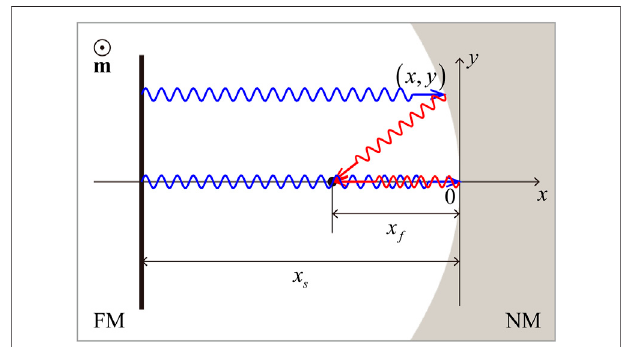
FIGURE 1 | Schematic of the fi lm edge for total-re fl ection focusing of spin waves. The static magnetization m is oriented along the + z direction. FM and NM denote the ferromagnetic and non-magnetic regions, respectively. The black bar located at x (cid:2) − x s is the spin wave source. A parallel incidentspinwave(bluewavylineswitharrow)propagatestowardsthecurved edge,andthere fl ectedspinwave(redwavylineswitharrow)convergesonthe focal point at x (cid:2) − x f (black